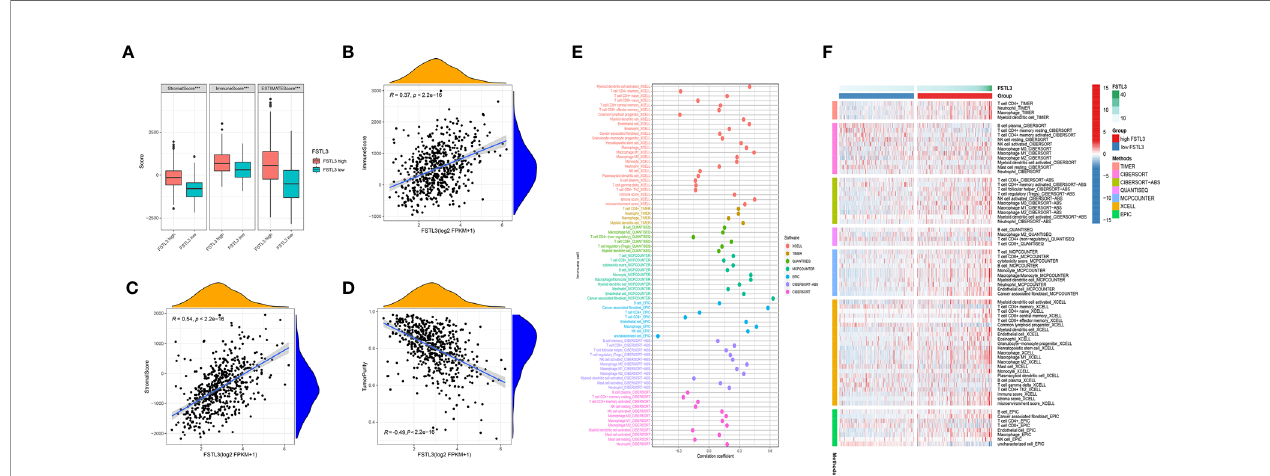
FIGURE 9 | Correlation Between FSTL3 and TME in CRC. (A) Both the higher ImmuneScore, StromalScore, and TumorPurity were found in high FSTL3 expression group. (B – D) The correlation analysis showed the FSTL3 expression has a observably positive association with ImmuneScore (B) , StromalScore (C) , but negative association with TumorPurity (D) in CRC. (E, F) The relationship between FSTL3 expression and immune cell in fi ltration is displayed in a bubble diagram (E) and heatmap (F) , respectively. *** P <